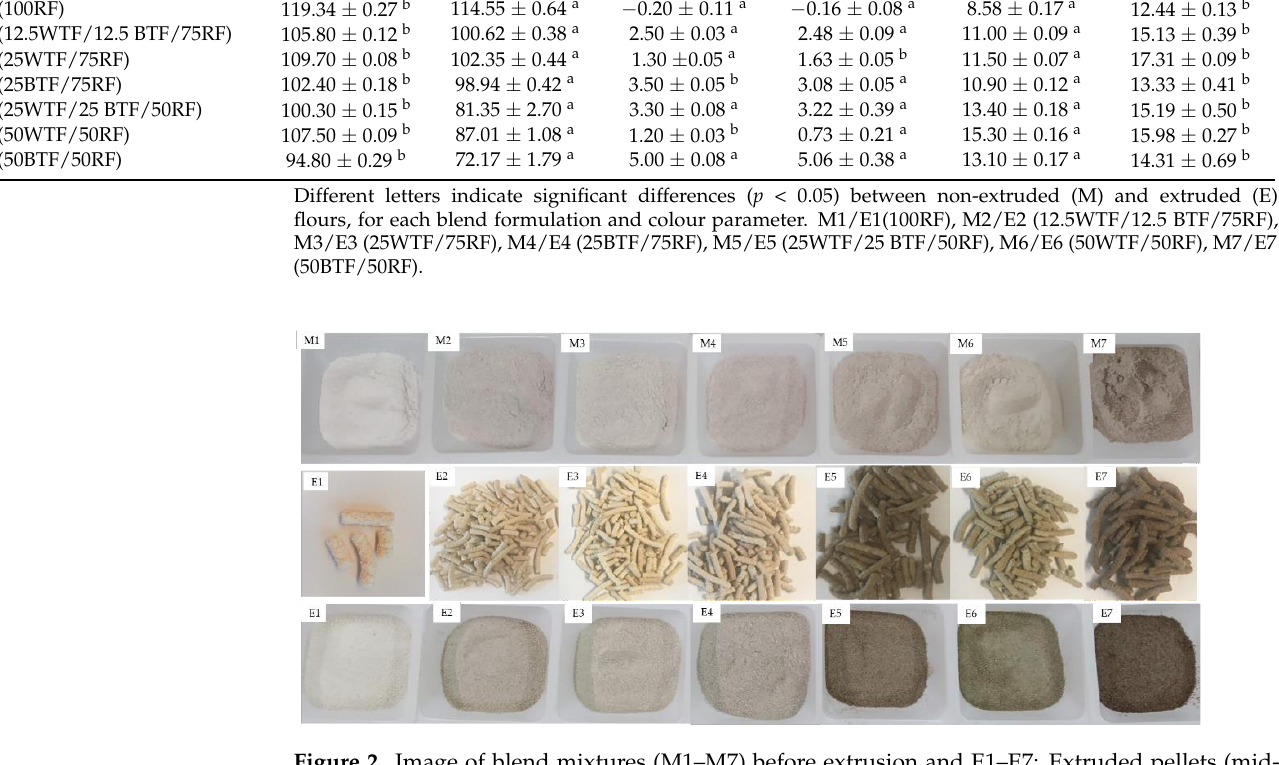
Figure 2. Image of blend mixtures (M1-M7) before extrusion and E1-E7: Extruded pellets (middle row) and flours produced from extruded (bottom row). M1/E1(100RF), M2/E2 (12.5WTF/12.5 BTF/75RF), M3/E3 (25WTF/75RF), M4/E4 (25BTF/75RF), M5/E5 (25WTF/25 BTF/50RF), M6/E6 (50WTF/50RF), M7/E7 (50BTF/50RF).